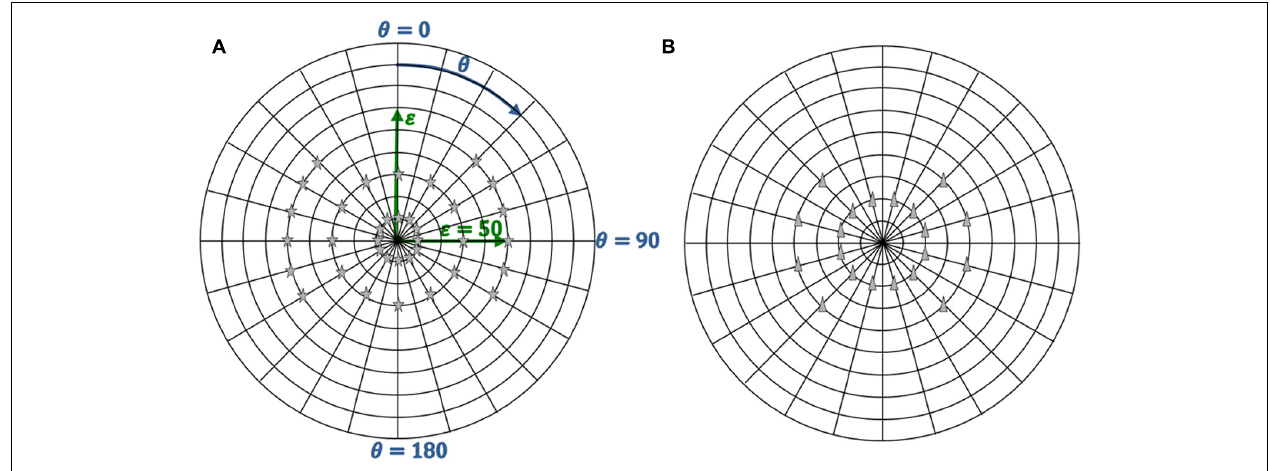
FIGURE 3 |Target and distractor positions. (A) Thirty-six targets positions. (B) Twenty distractors